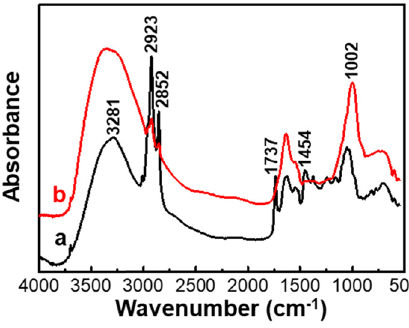
Figure 5: E ff ect of adsorbent dose on ( a ) the adsorption e ffi ciency and ( b ) the equilibrium adsorption of Cd 2 + on pollen@FePO 4 60